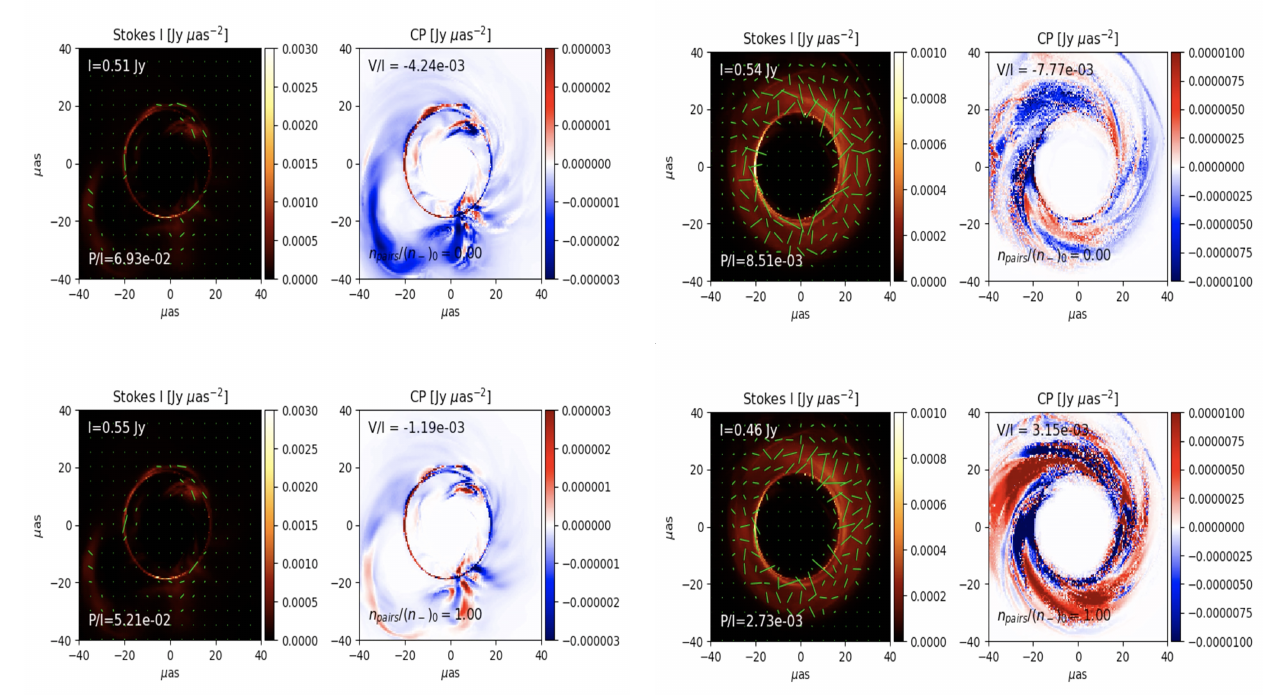
Figure 9. For a = − 0.5 at 230 GHz and at T = 25,000 M : ( Top ) Critical Beta Model without positrons; ( Bottom ) Critical Beta with n pairs / n 0 = 1.We also compare MAD ( Left ) and SANE ( Right